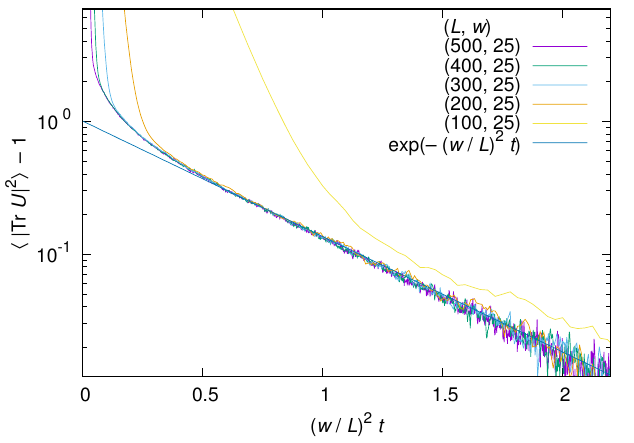
Figure 29 . Plot of ( hj Tr U j 2 i (cid:0) 1) = ( L 2 (cid:0) 1) against t for w = 25 and various values of L (left) and for L=w = 20 with L = 500 ; 200 ; 100 (right). dt = 0 : 5 is (cid:12)xed.